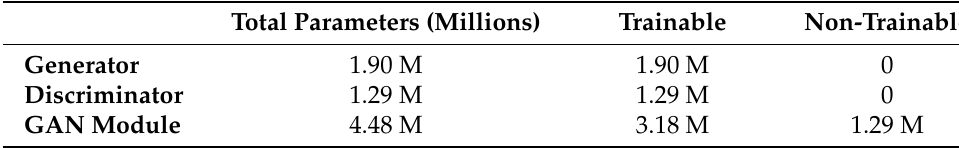
Table 2. Number of trainable and non-trainable parameters in